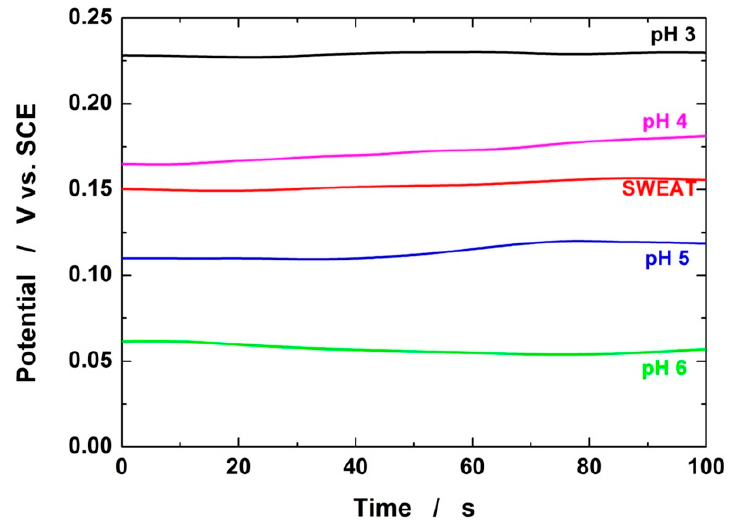
Figure 7. OCP vs. time curves for sweat real sample and for buffer solution at different pH.